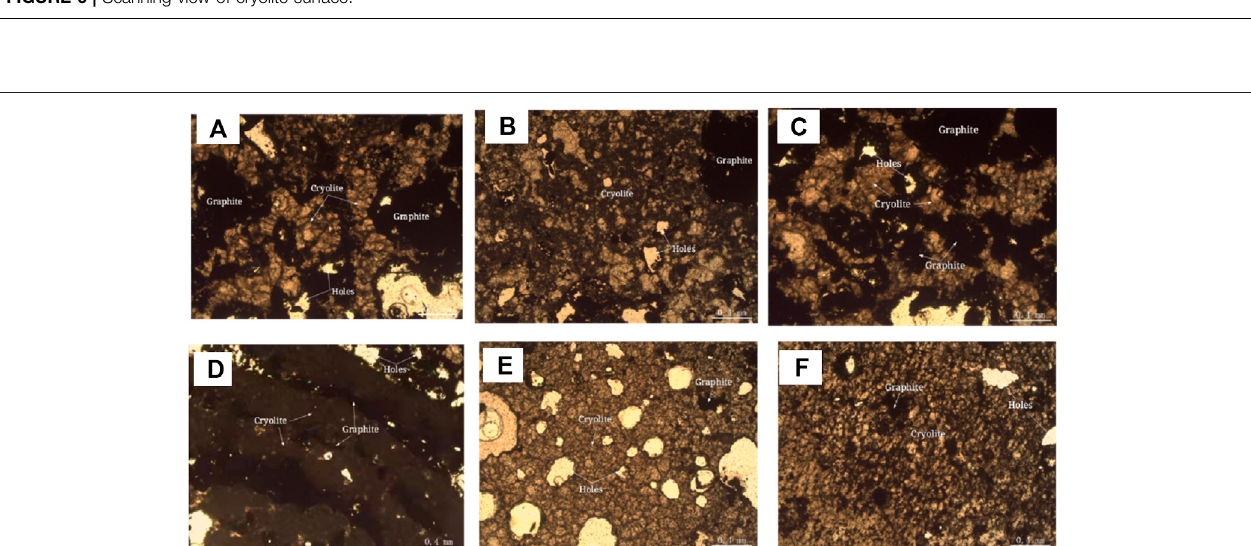
FIGURE 6 | Scanning view of cryolite surface.